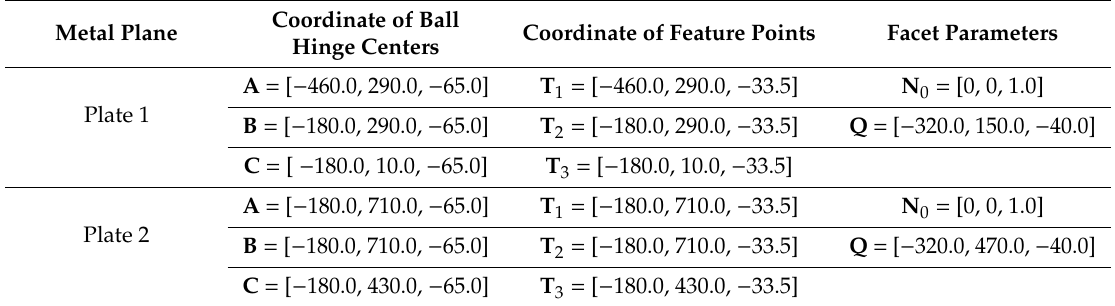
Table 2. Coordinates of the ball-hinge centers, feature points and facet parameters of Plate 1 and